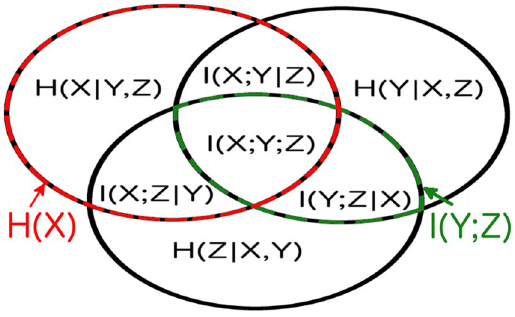
Figure 1. The information diagram for three variables. It contains 7 regions corresponding to the possible combinations of 3 variables, with their corresponding information-theoretic quantities defined in the text. The univariate entropy H ( X ) is the sum of all the regions in the red and black striped circle, and the mutual information I ( Y ; Z ) is the sum of all the regions in the black and green striped